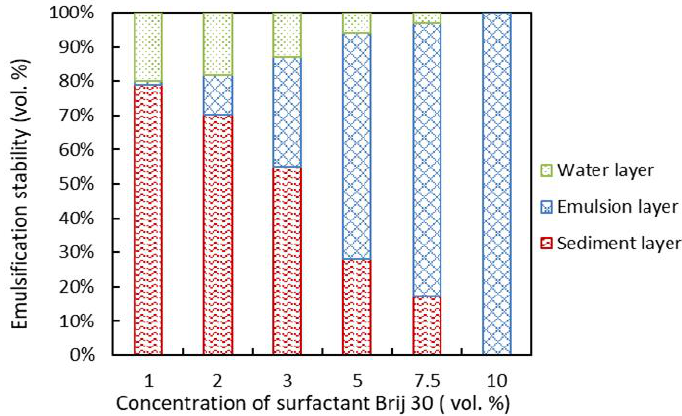
Figure 7. Effects of surfactant Brij 30 concentrations on emulsification stability.